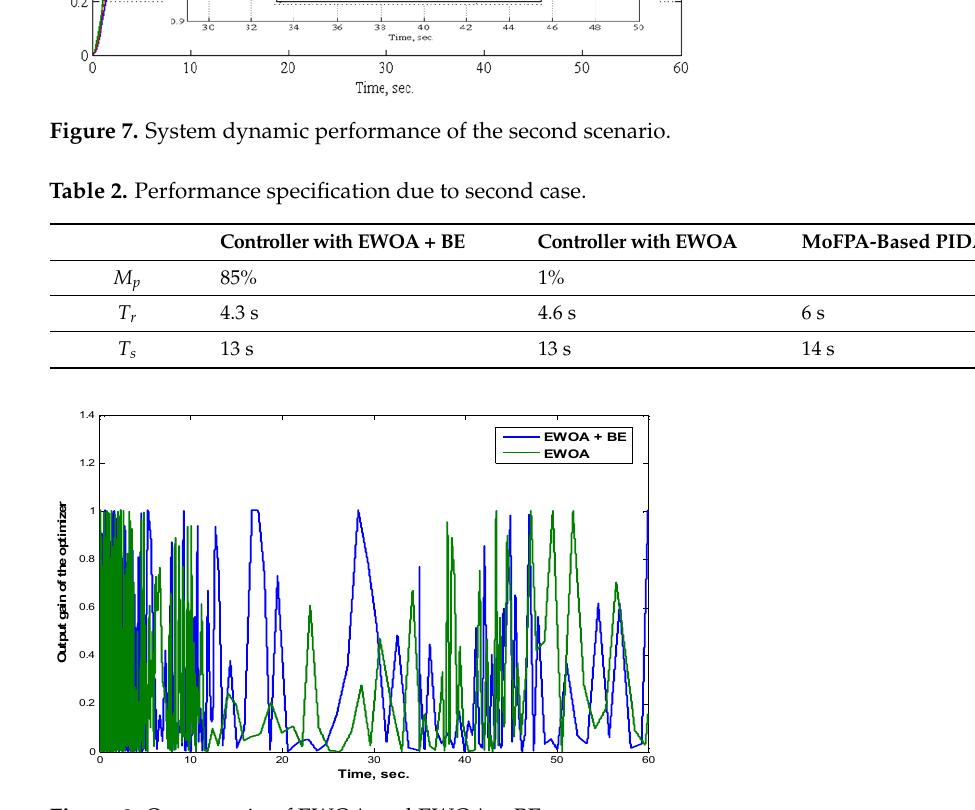
Figure 8. Output gain of EWOA and EWOA + BE.